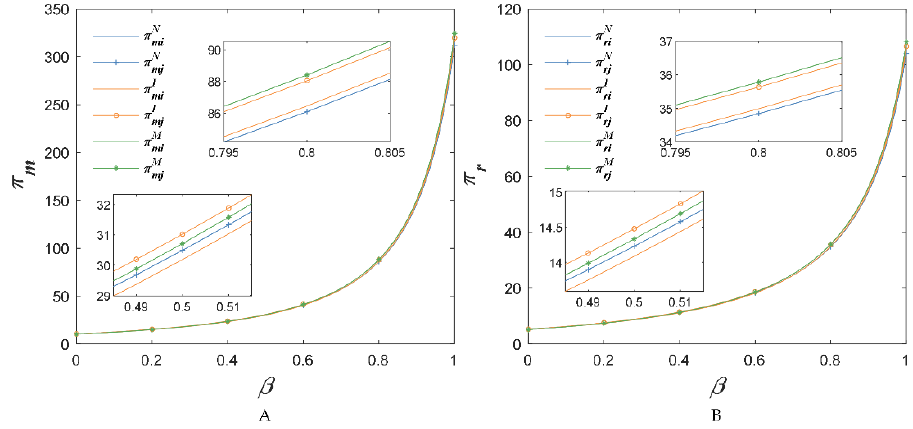
Figure 9. The price sensitivity coefficient of competitive agricultural products’ impact on income of suppliers ( A ) and retailers ( B ), when c om = 0.22 and c or = 0.22.